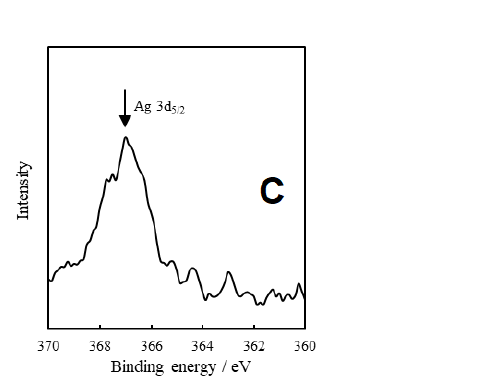
Figure 4. SEM image and EDX and XPS spectra of OS-AgNPs. ( A ) The morphology of the OSM- AgNPs was found to be irregularly granulated and highly aggregated, with some presenting a cubic shape. ( B ) The strong absorption peak at 3 keV confirmed the presence of silver. ( C ) The observed peak of Ag 3d 5/2 around 367 eV confirmed the existence of silver atoms.